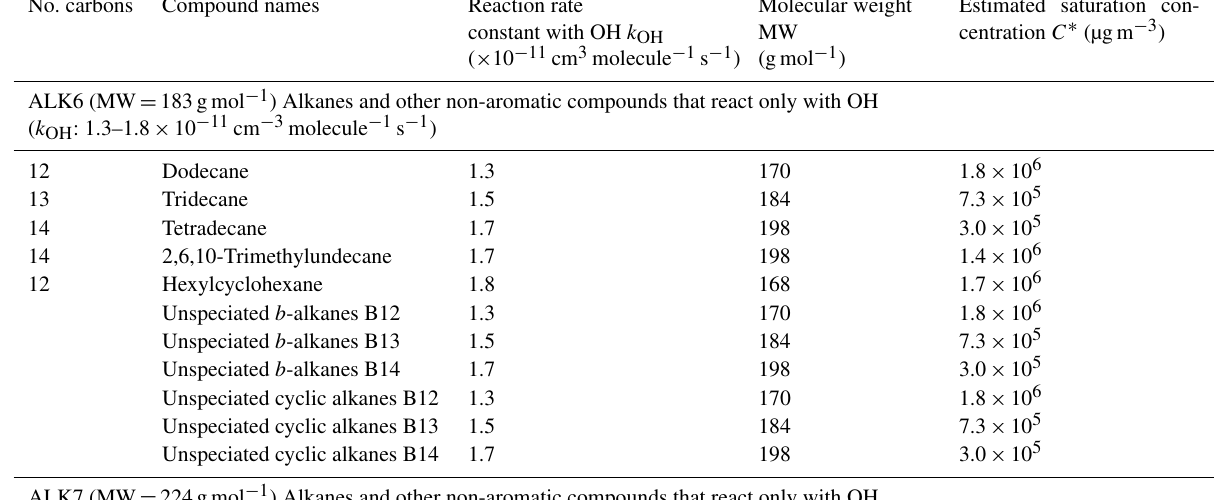
Table 1. Characteristics of the new lumped IVOC species. No.